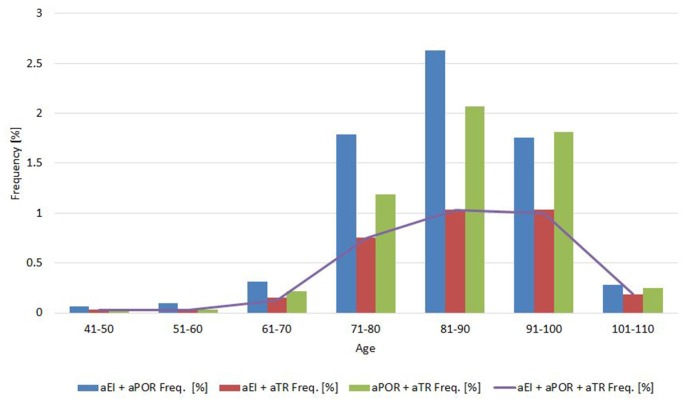
Proportion of abnormal values for pairs of (and all) neuroimaging measures in 10-year age cohorts.